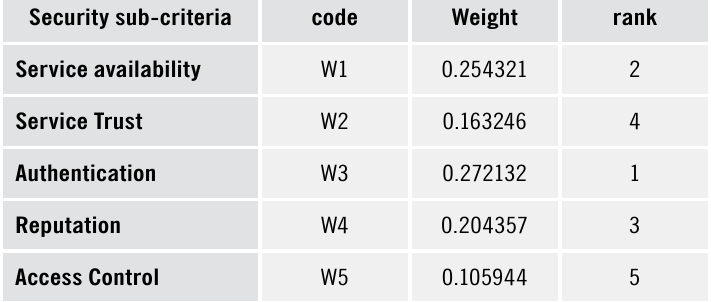
Table 9. Weight of security sub-criteria in service (taken from the fuzzy nonlinear model) Security